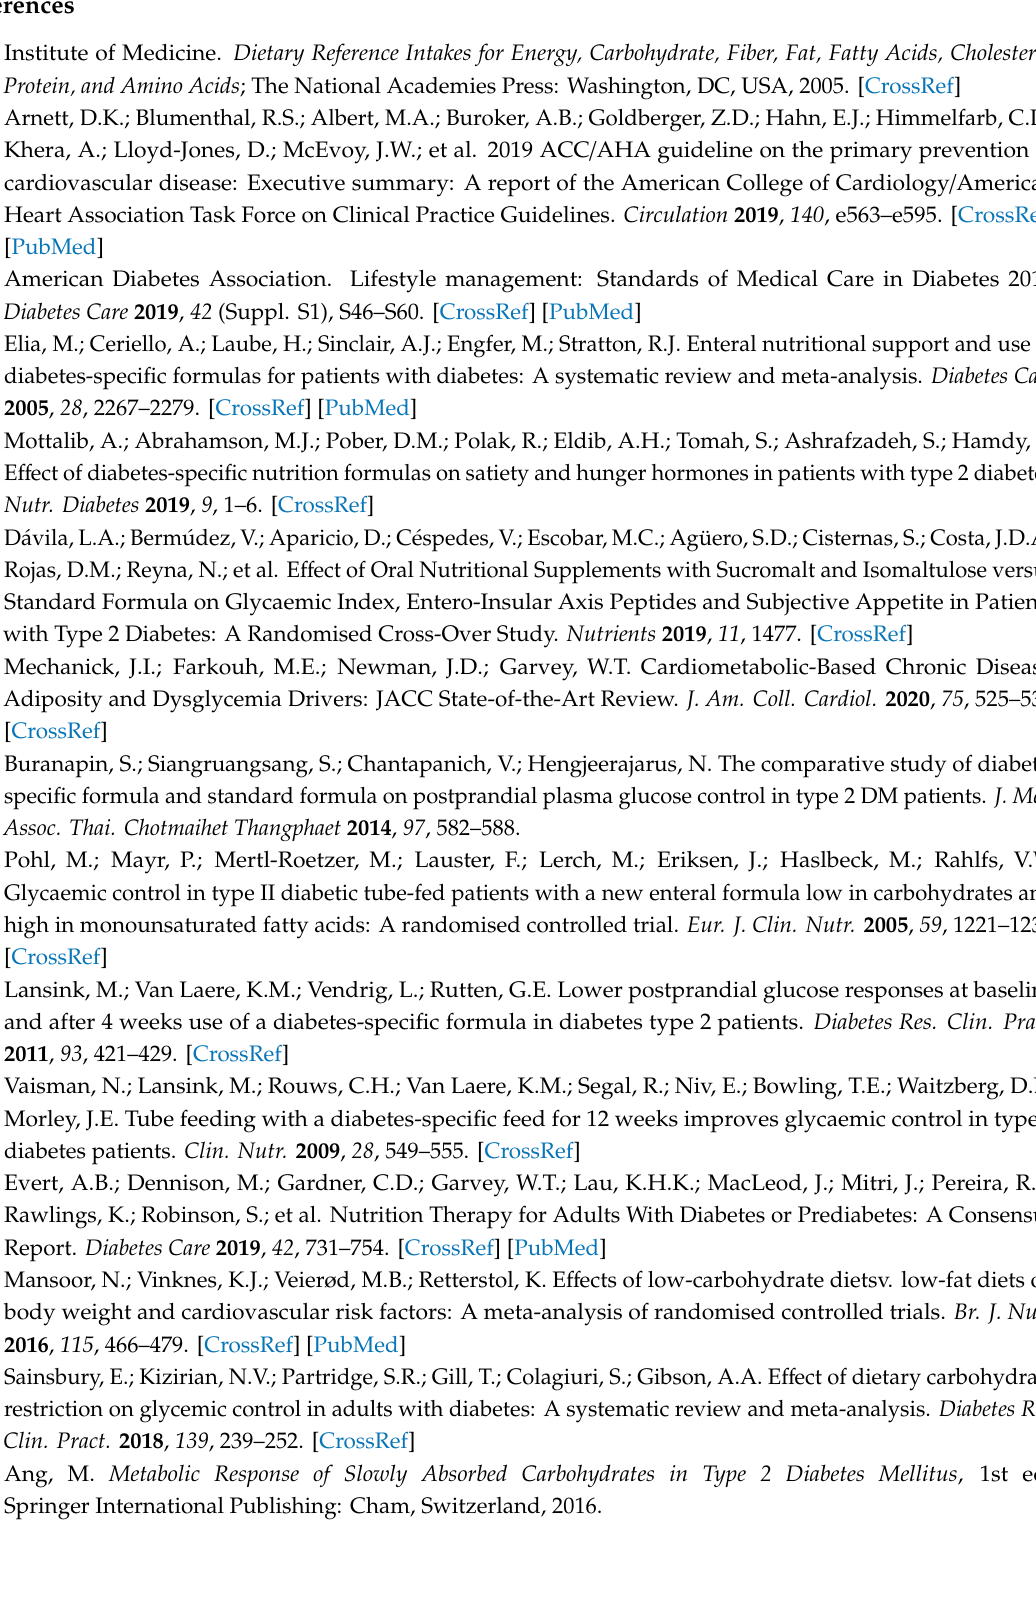
T1D—type 1 diabetes, T2D—type 2 diabetes, tDNA—transcultural Diabetes Nutrition Algorithm,